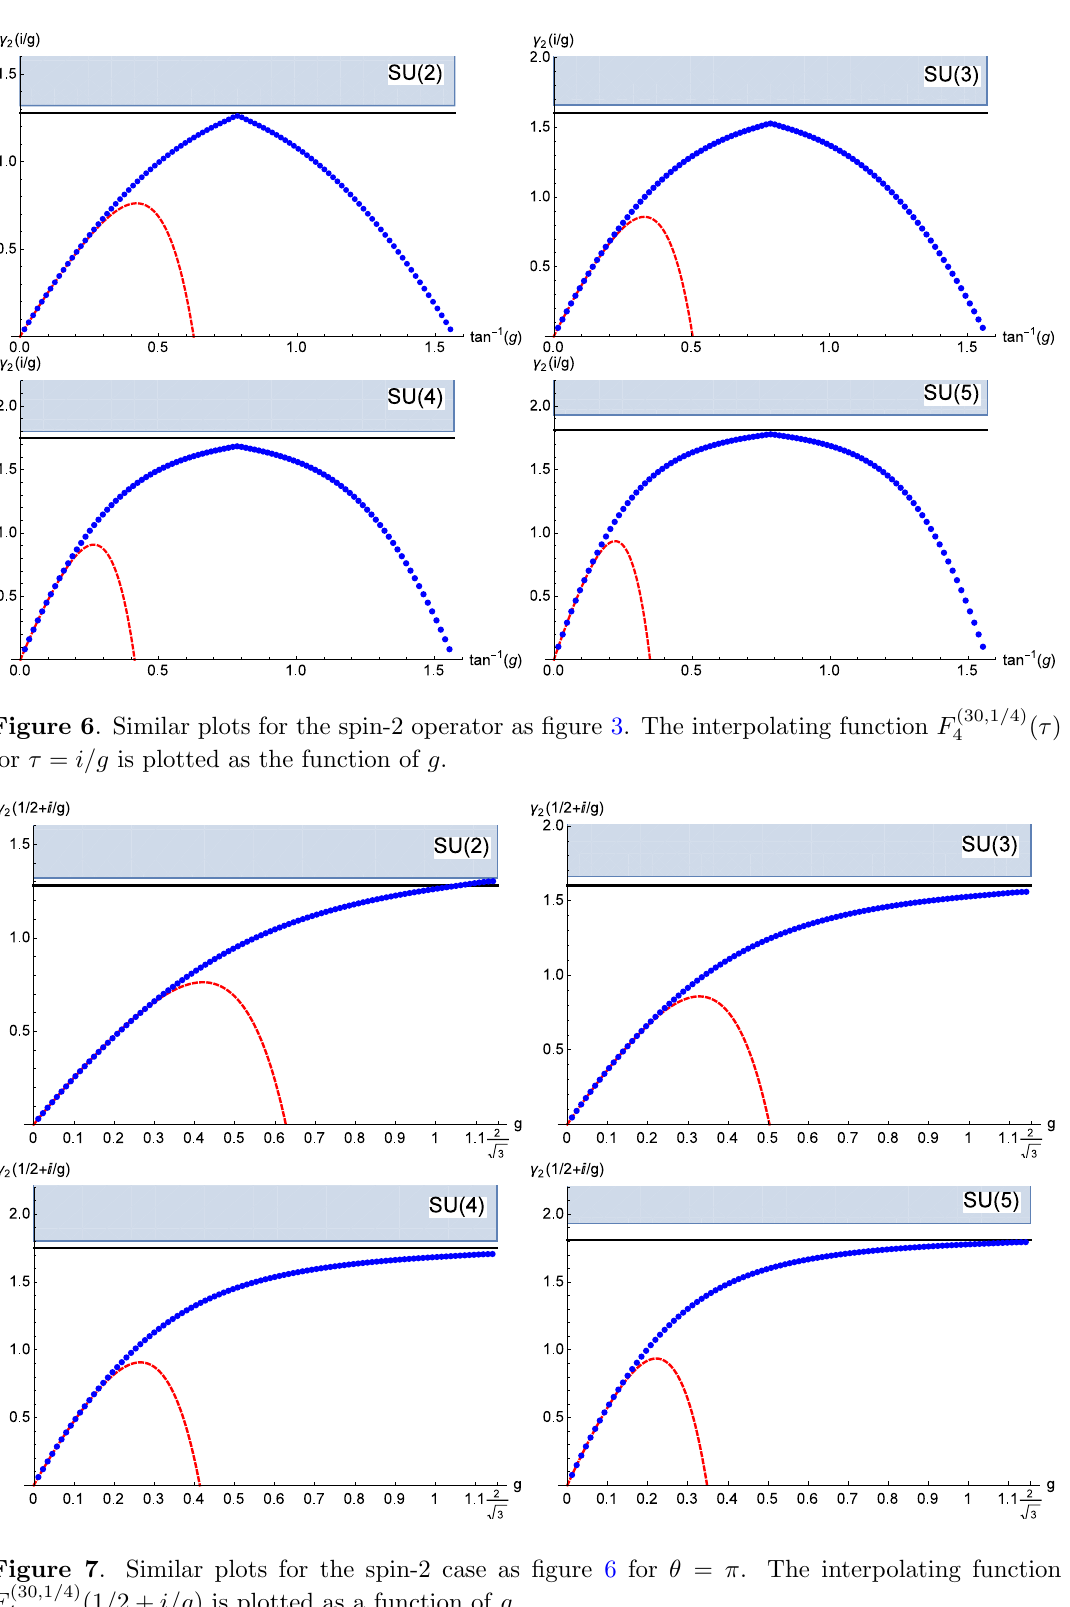
Figure 7 . Similar plots for the spin-2 case as (cid:12)gure 6 for (cid:18) = (cid:25) . The interpolating function (1 = 2 + i=g ) is plotted as a function of g . F (30 ; 1 = 4) 4